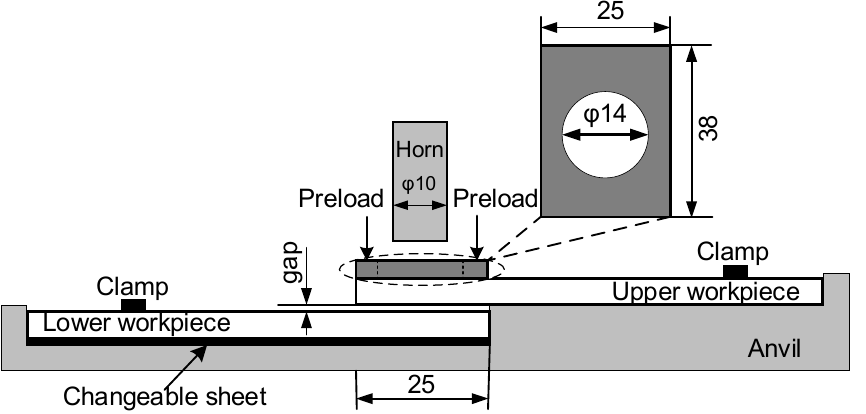
Figure 3. Schematic of ultrasonic welding with preload and gap between upper and lower workpieces (Dimensions in mm).